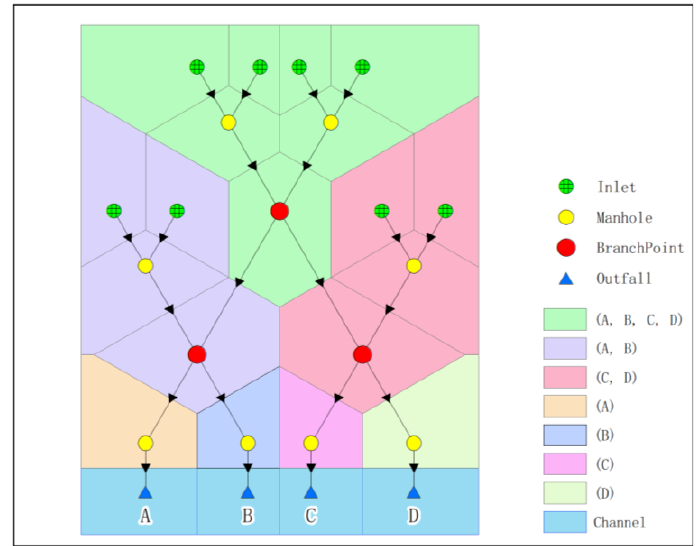
Figure 4. Subcatchment based on potential outfall.